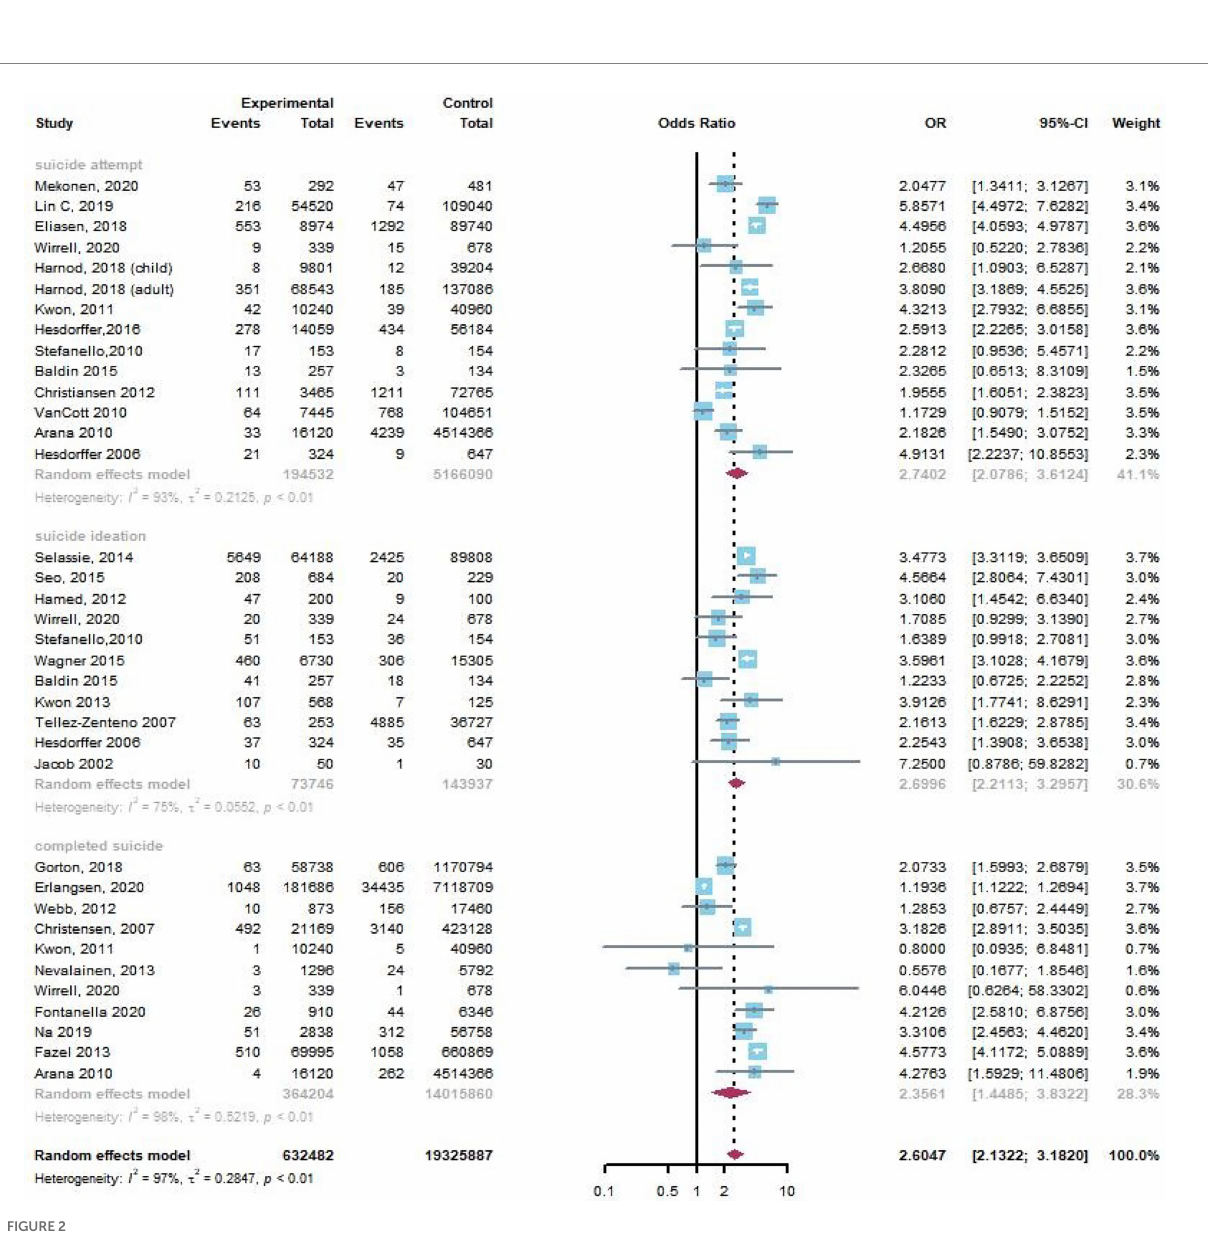
other measurements of suicidality (Interview vs. Questionnaire vs.